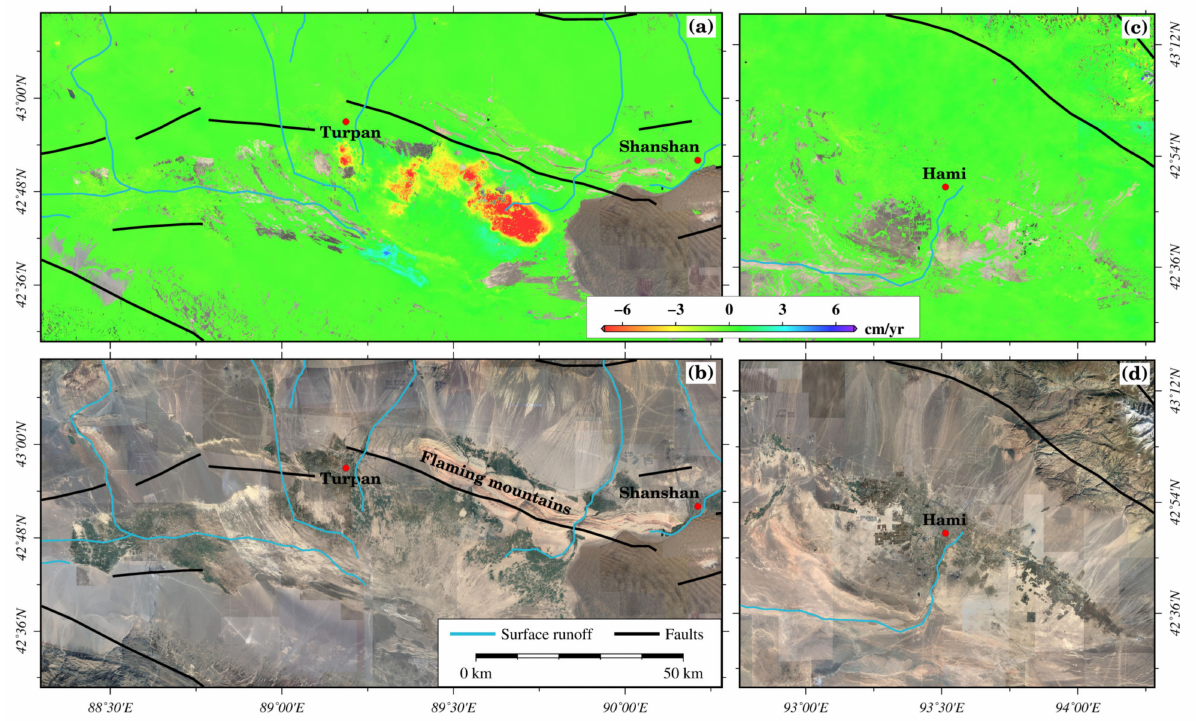
Figure 11. Comparison of ground deformation and optical images in ( a , b ) Turpan and ( c , d ) Hami oases. Background image: Google Maps satellite